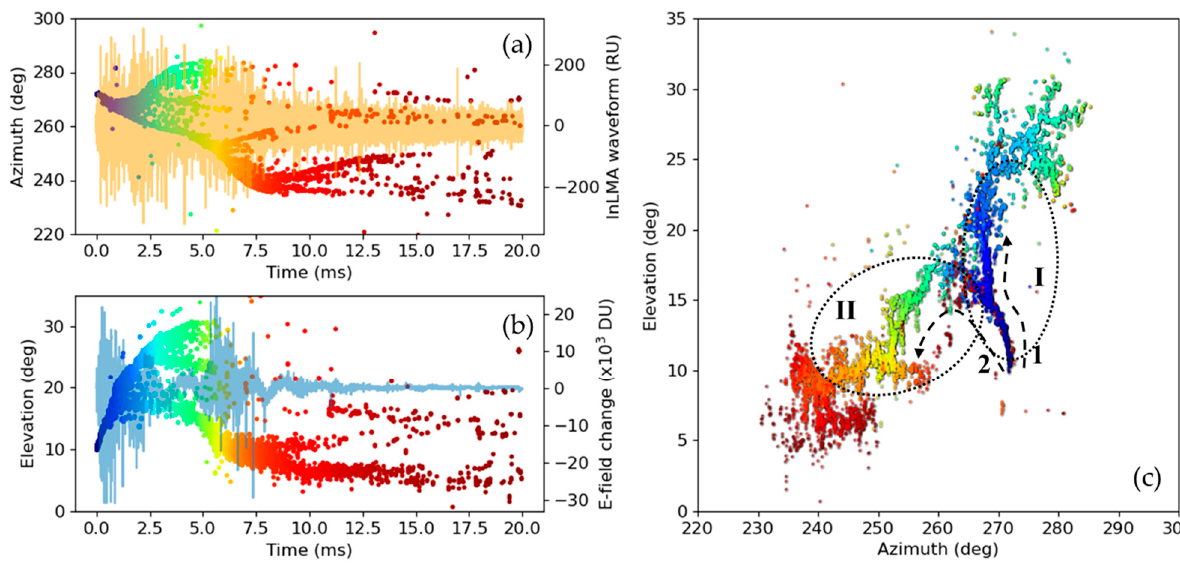
Figure 8. 2D result from station 3 of InLMA. ( a ) Azimuth result with InLMA waveform versus time; ( b ) Elevation result with E-field change versus time; ( c ) 2D view of azimuth versus elevation with two branches, 1 and 2,